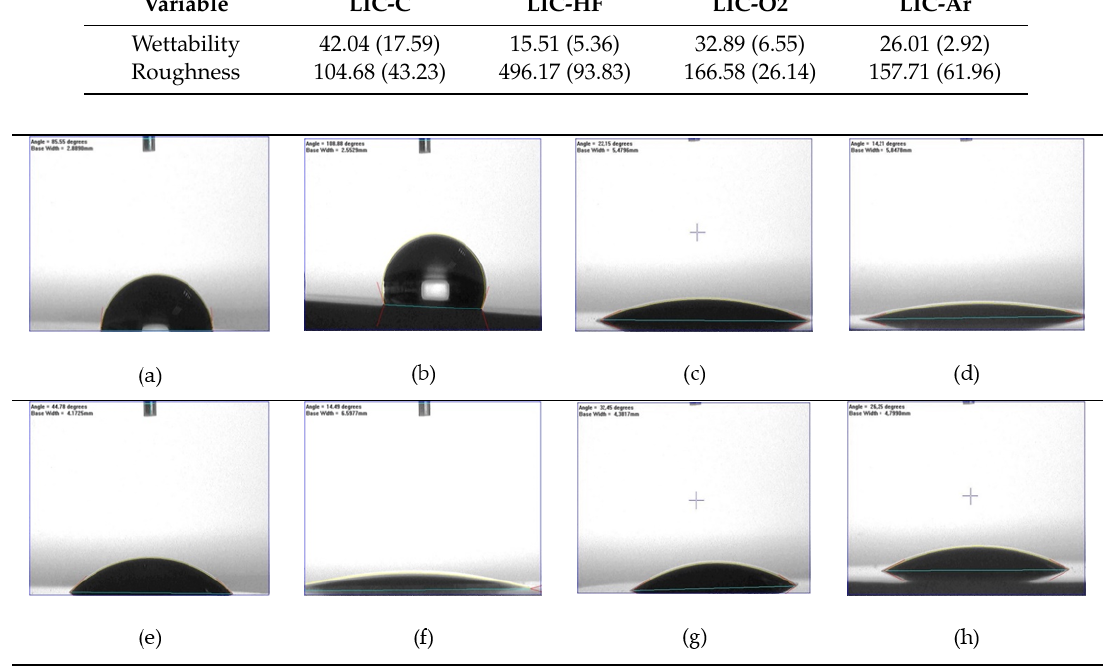
Figure 2. Water drop images on the surface of the representative specimens of each group: ( a ) RMC-C; ( b ) RMC-SB; ( c ) RMC-O2; ( d ) RMC-Ar; ( e ) LIC-C; ( f ) LIC-HF; ( g ) LIC-O2; ( h ) LIC-Ar. RMC: resin matrix ceramic; SB; sandblasting. Appl. Sci. 2020 , 10 , x FOR PEER REVIEW